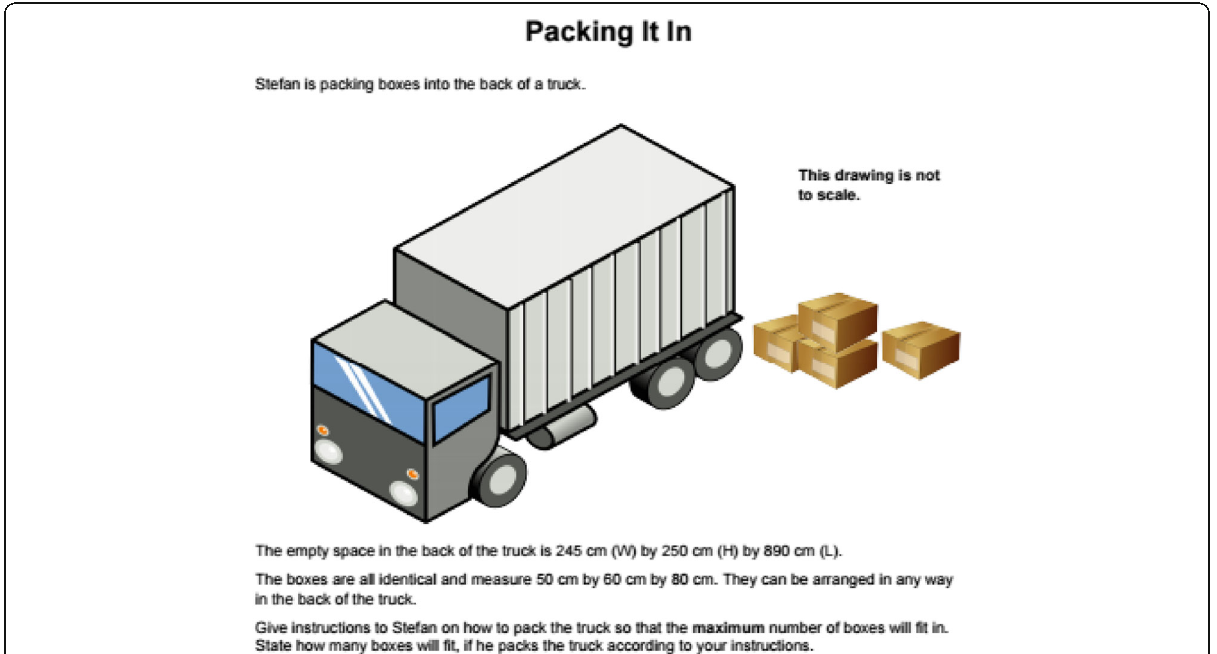
Fig. 3 Adapted from Mathematics Assessment Resource Service. (2016). Using space efficiently: packing a truck. retrieved from http://map.mathshell.org/